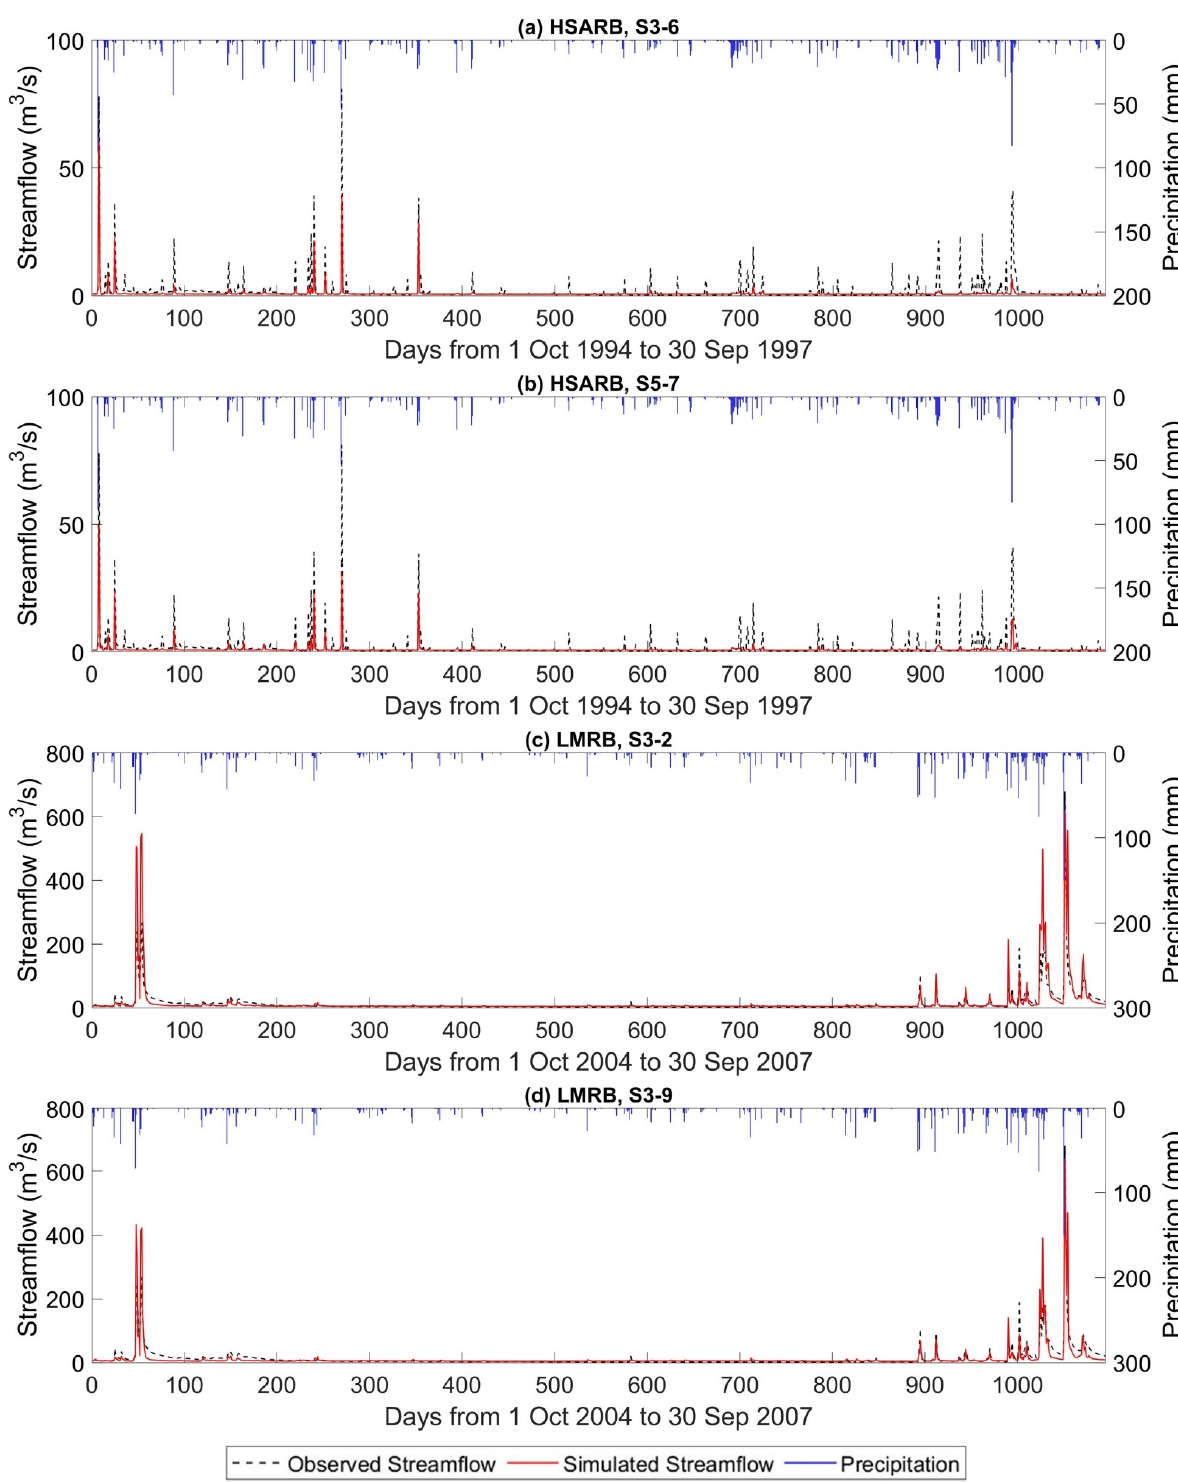
Figure 5. Daily precipitation, observed, and simulated streamflow of testing phase for ( a ) HSARB, S3-6; ( b ) HSARB, S5-7; ( c ) LMRB S3-2; ( d ) LMRB S3-9.